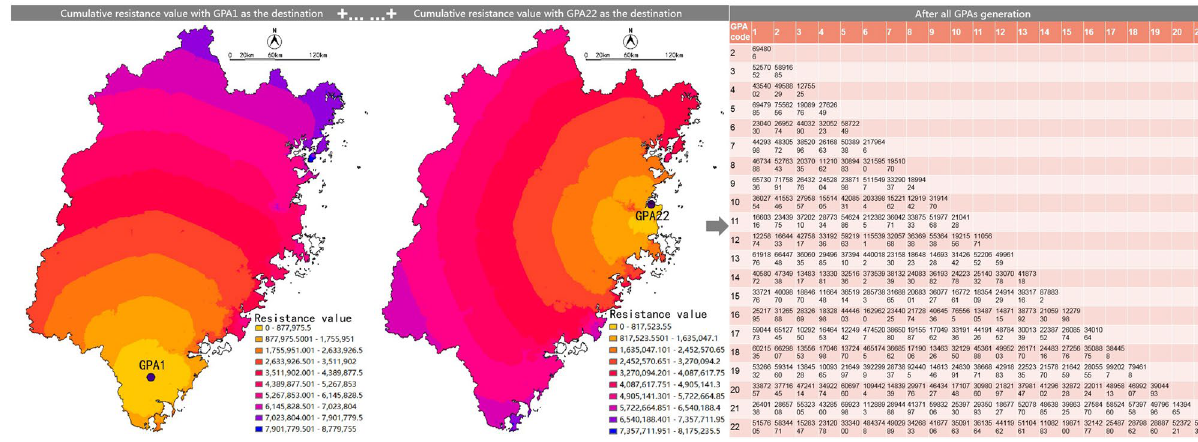
Figure 8. Schematic diagram of L ab .